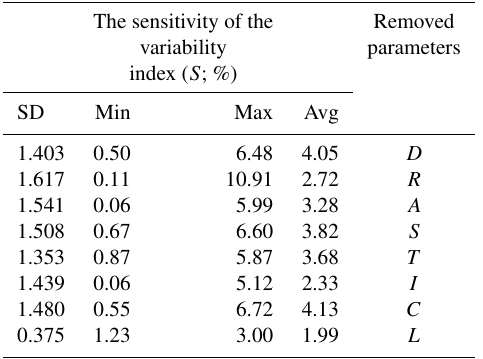
Table 10. Statistical results of MRSA in the CDRASTIC index. The sensitivity of the Removed variability